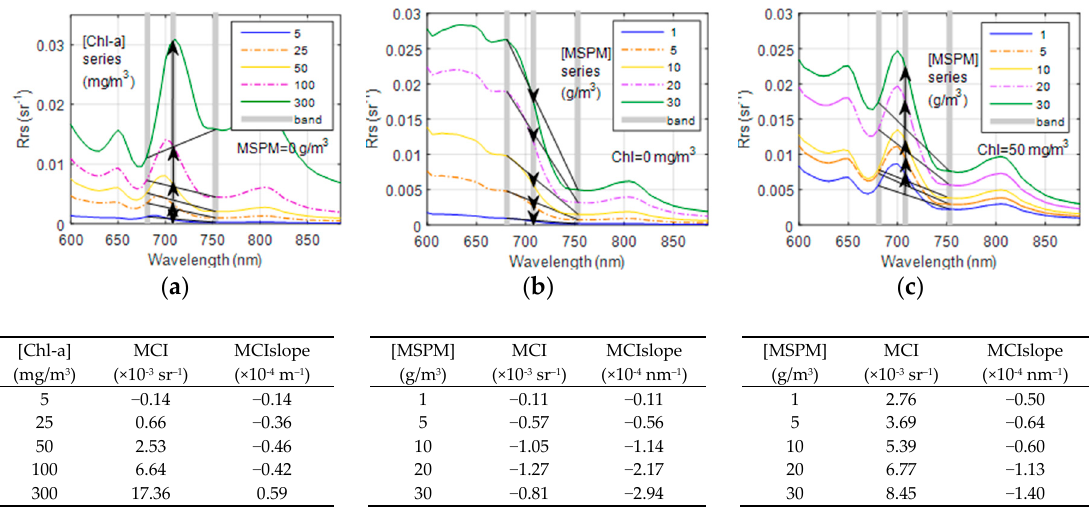
Figure 5. Modeled reflectance spectra and derived MCI and MCI slope for ( a ) varying [Chl-a] in the absence of MSPM, ( b ) varying [MSPM] in the absence of Chl-a, and ( c ) [Chl-a] = 50 mg/m 3 and increasing [MSPM], showing the effect of MSPM on baseline slopes.